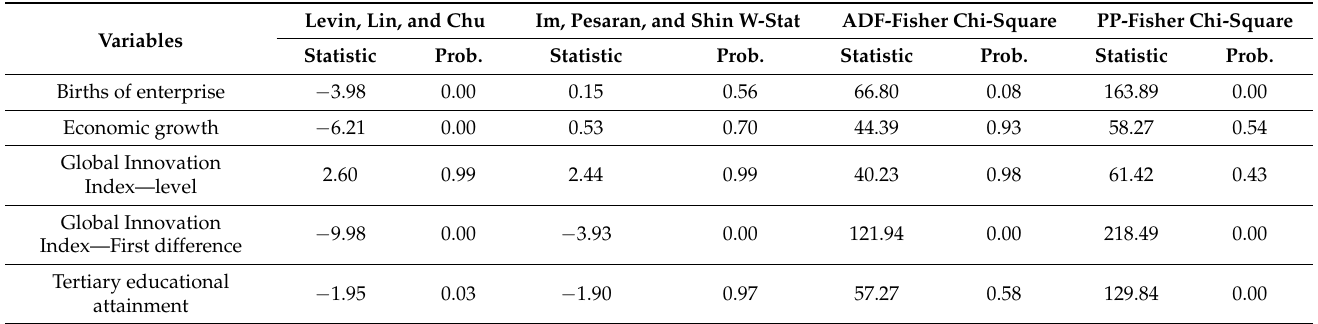
Table 4. Unit root tests for the full